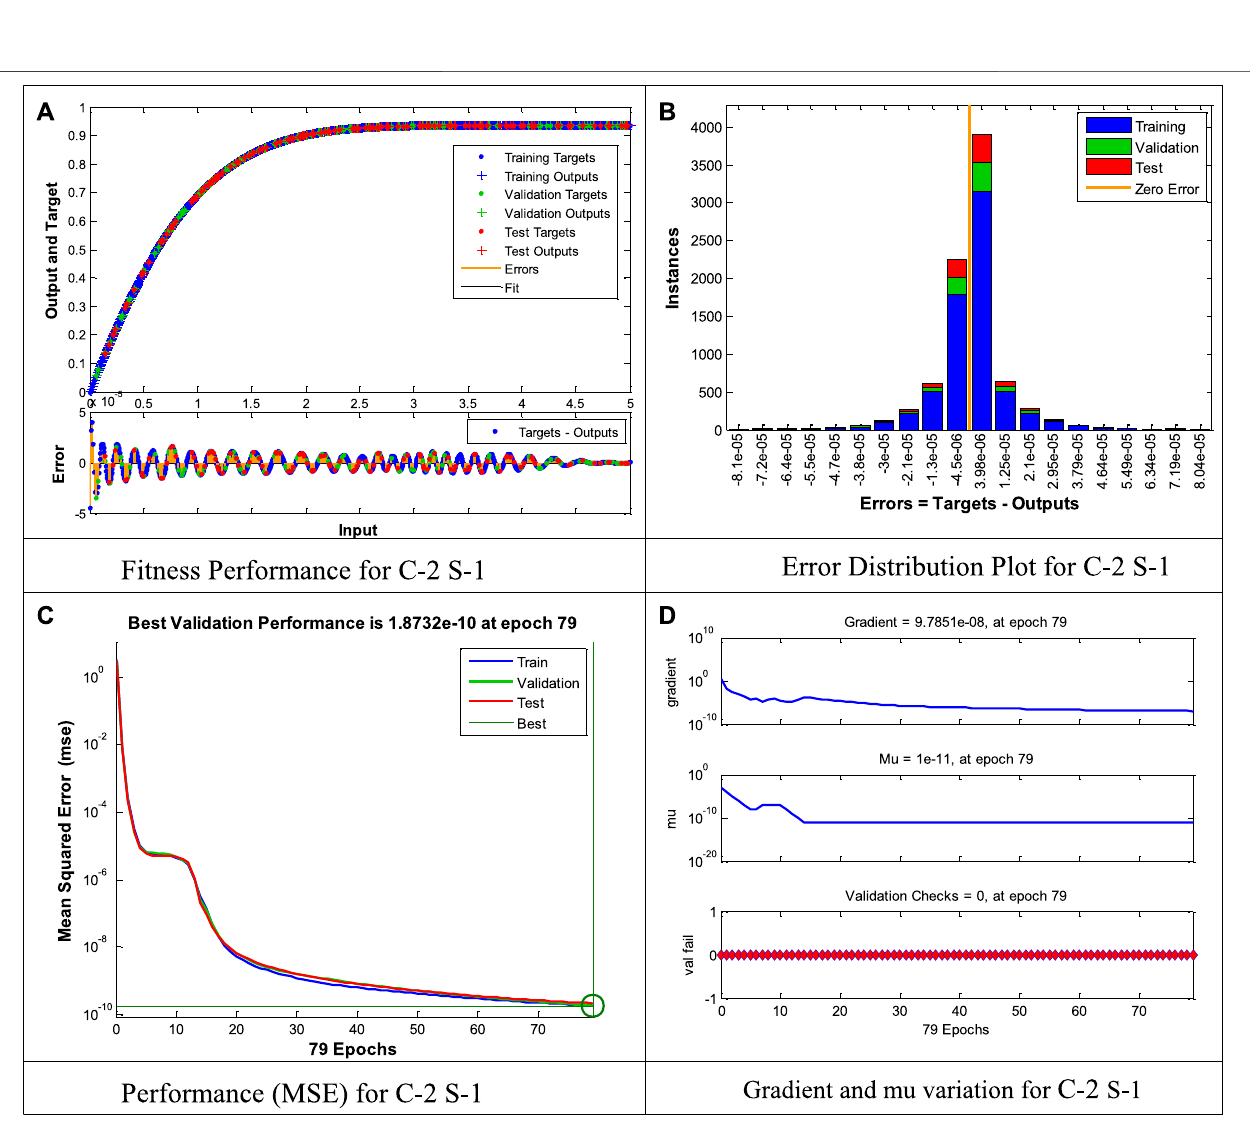
FIGURE 6 | Performance and accuracy plots of C-2